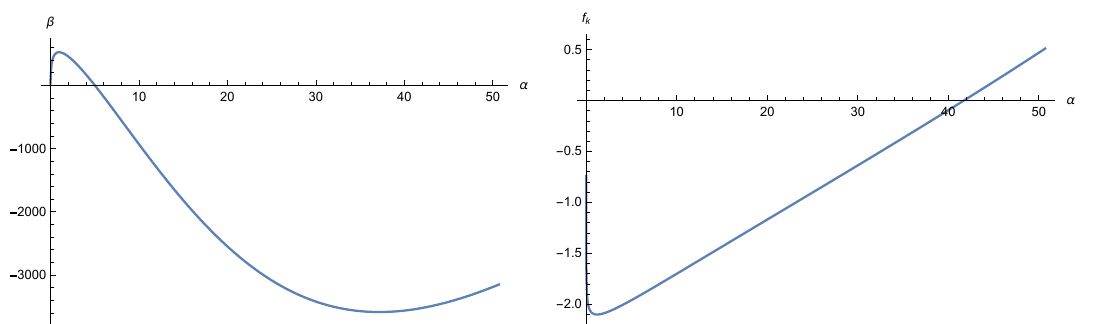
Figure 3 . Plots of (cid:12) vs (cid:11) and f k vs (cid:11) . The relationships between the three parameters f k , (cid:11) , and (cid:12) may in principle be used to express the UV asymptotic expansion (5.1) in terms of only a single independent